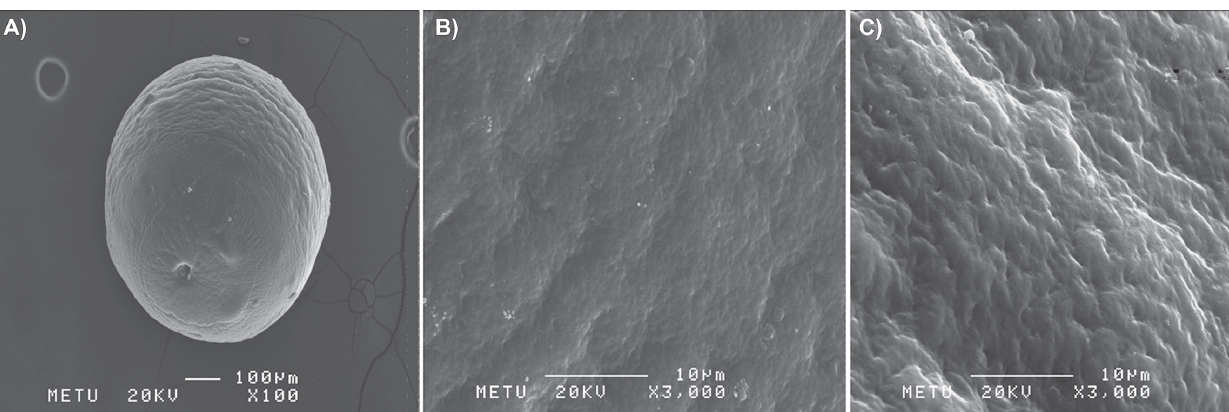
FIGURE 4 - Scanning electron micrographs of F2 coded chitosan microspheres after 24 hours in dissolution test: (A) general appearance and surface morphology (B, C). TABLE III - Particle size analysis and incorporation efficiencies of formulations Formule